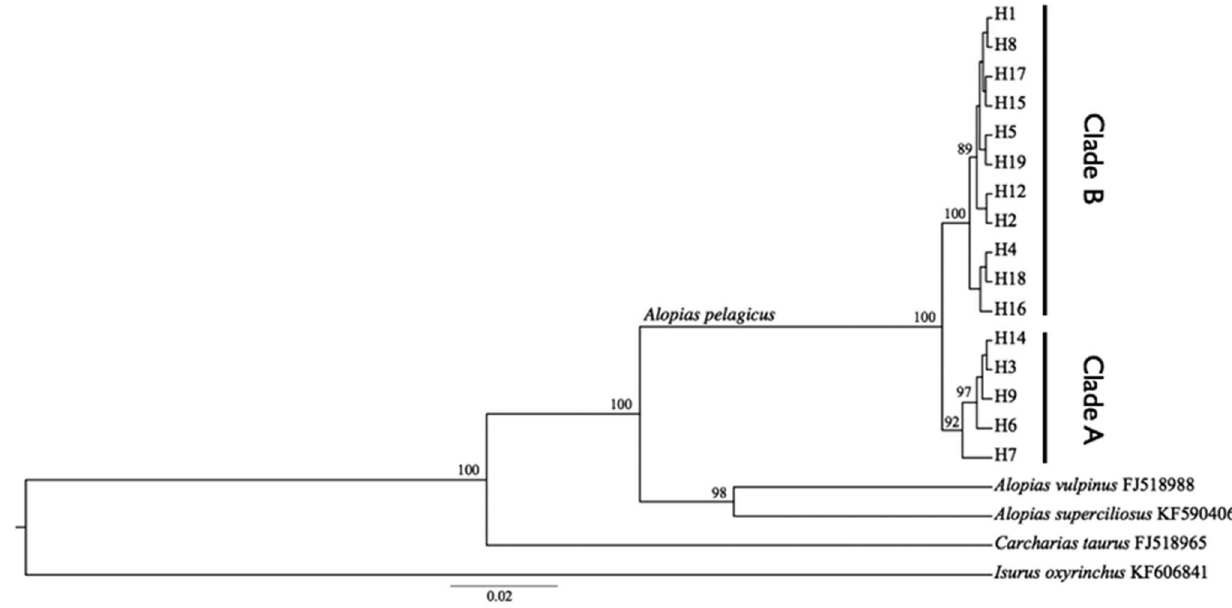
Figure 3. Coalescent tree showing reciprocal monophyly between haplotypes from the A and B clades. Posterior values are shown as branch labels. doi:10.1371/journal.pone.0110193.g003 72 u C for 90 s, with a final extension of 72 u C for 30 min. The